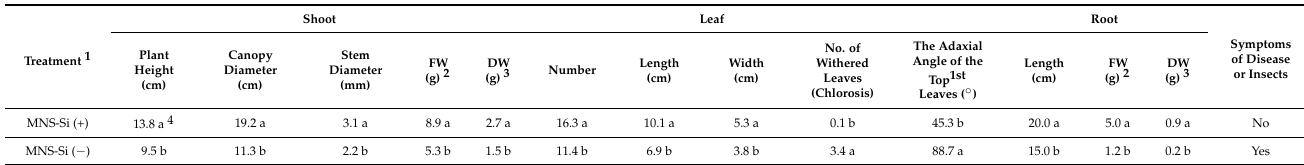
Table 1. Influence of 30 days silicon application on morphological characteristics in the coffee plants grown in plant growth chambers.